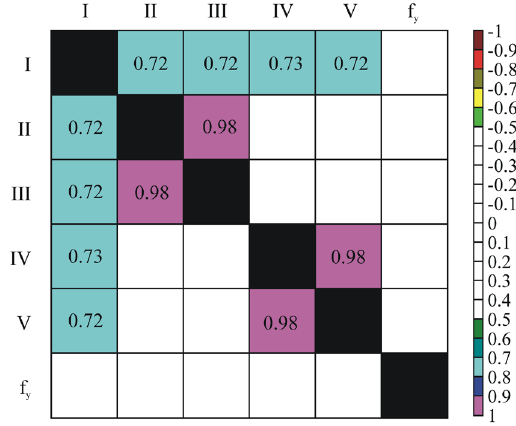
Fig. 9. Correlation among LCC cases and yield strength f